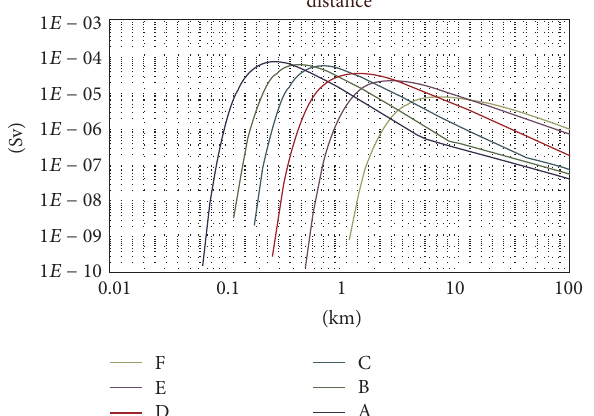
Figure 2: TEDE as a function of downwind distance from the NPP site in different stability classes (A–F).